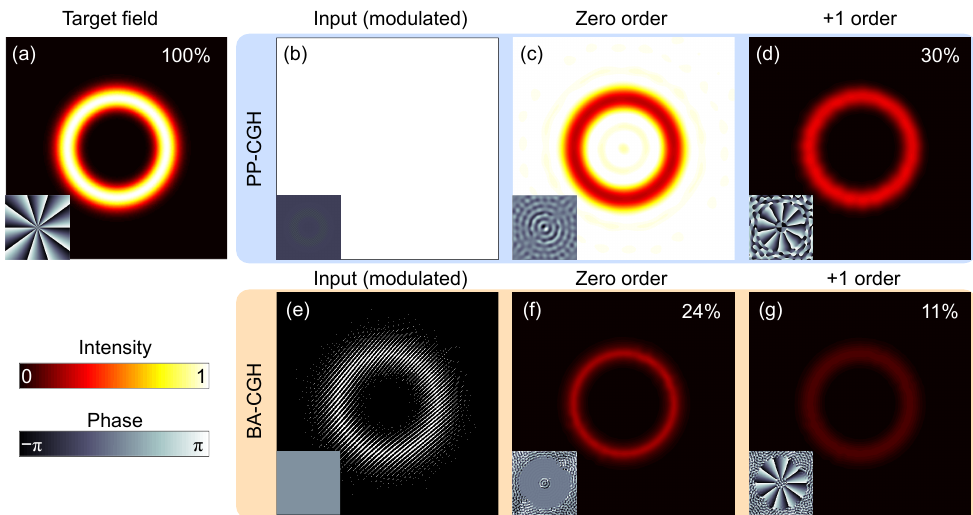
Figure 7. Schematic of tailoring of vortex beams ( (cid:96) = 10) with PP-CGH and BA-CGH methods, ( a ) energy of target is 100%, ( b – d ) and ( e – g ) are the modulated normalized light field distribution of input light, 0th order, and +1st order in the PP-CGH and BA-CGH method, respectively, while extraction efficiencies (inserted in upper right coner) of PP-CGH method and BA-CGH method are 30% and 11%, respectively.